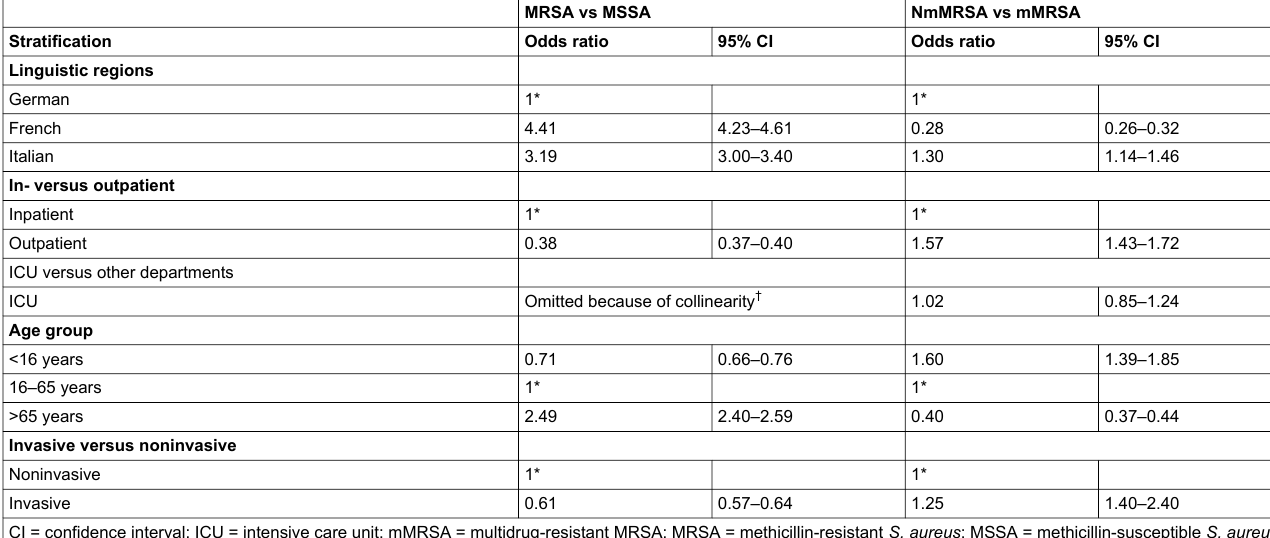
Table 2B: Results from multivariate logistic regression comparing the risk factors for MRSA versus MSSA and NmMRSA versus